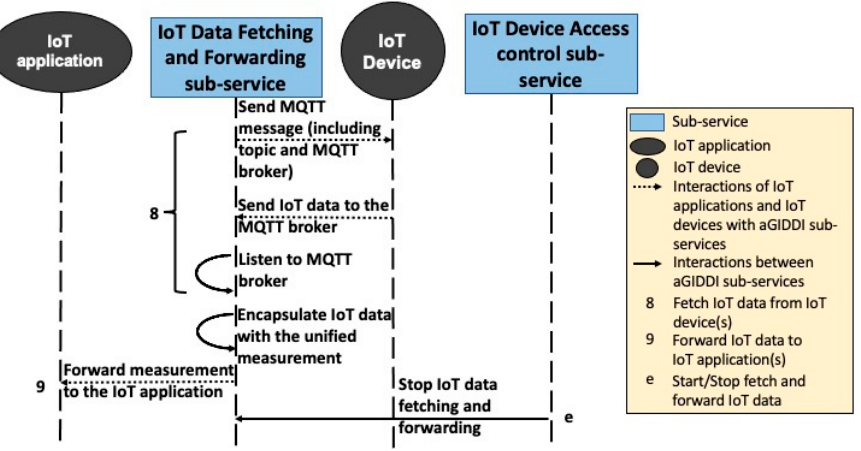
Figure 11. aGIDDI protocol for IoT device integration (fetching IoT data from IoT devices and forwarding it to IoT application).